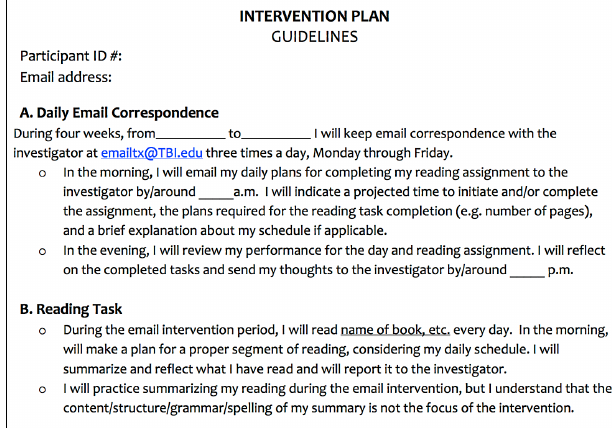
Table 1 Subtests of the Delis-Kaplan Executive Function System TM and Cognitive Functions Tested (D-KEFS; Delis, Kaplan, & Kramer, 2001)